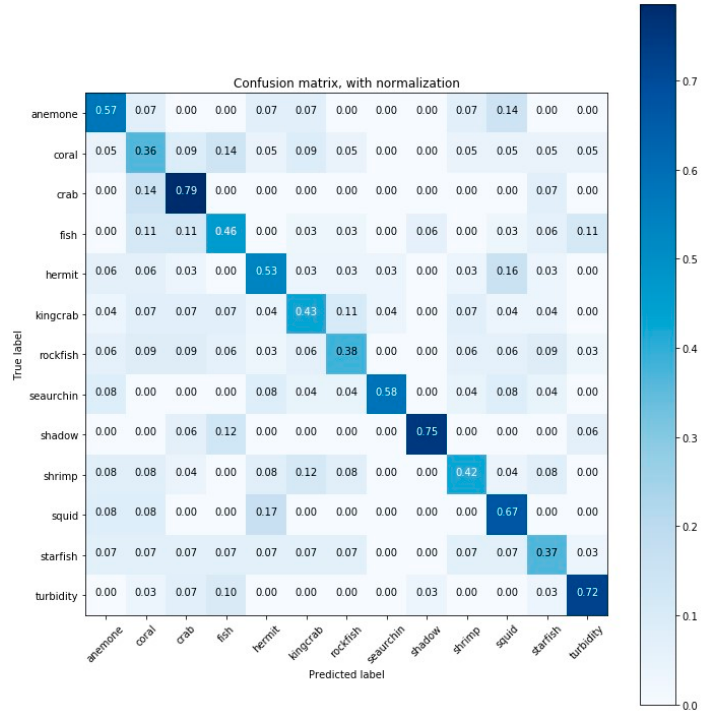
Figure A8. Confusion matrix for the classification results (accuracy) obtained by convolutional neural network (CNN) CNN-1.